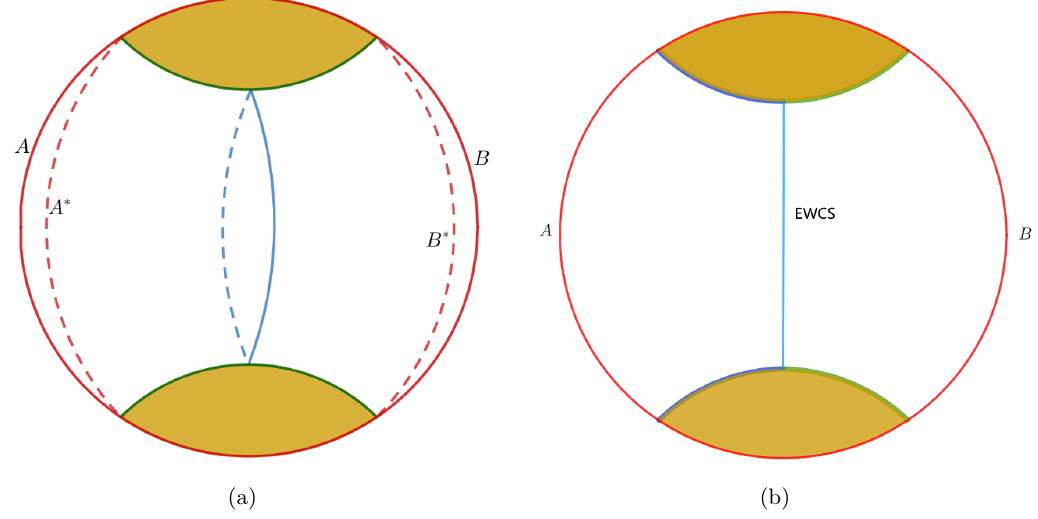
Figure 3 . Two dynamical constructions of EWCS. The left figure (a) shows the cutting and gluing procedure. The field theory living on AA ∗ , BB ∗ independently is the same as the original one. The Green lines denote γ which is the RT surface of AB . The right figure (b) shows that viewing the AB union of blue part of γ and A as the new subregion (the union of green part of γ AB complement), and EWCS is just the minimal RT